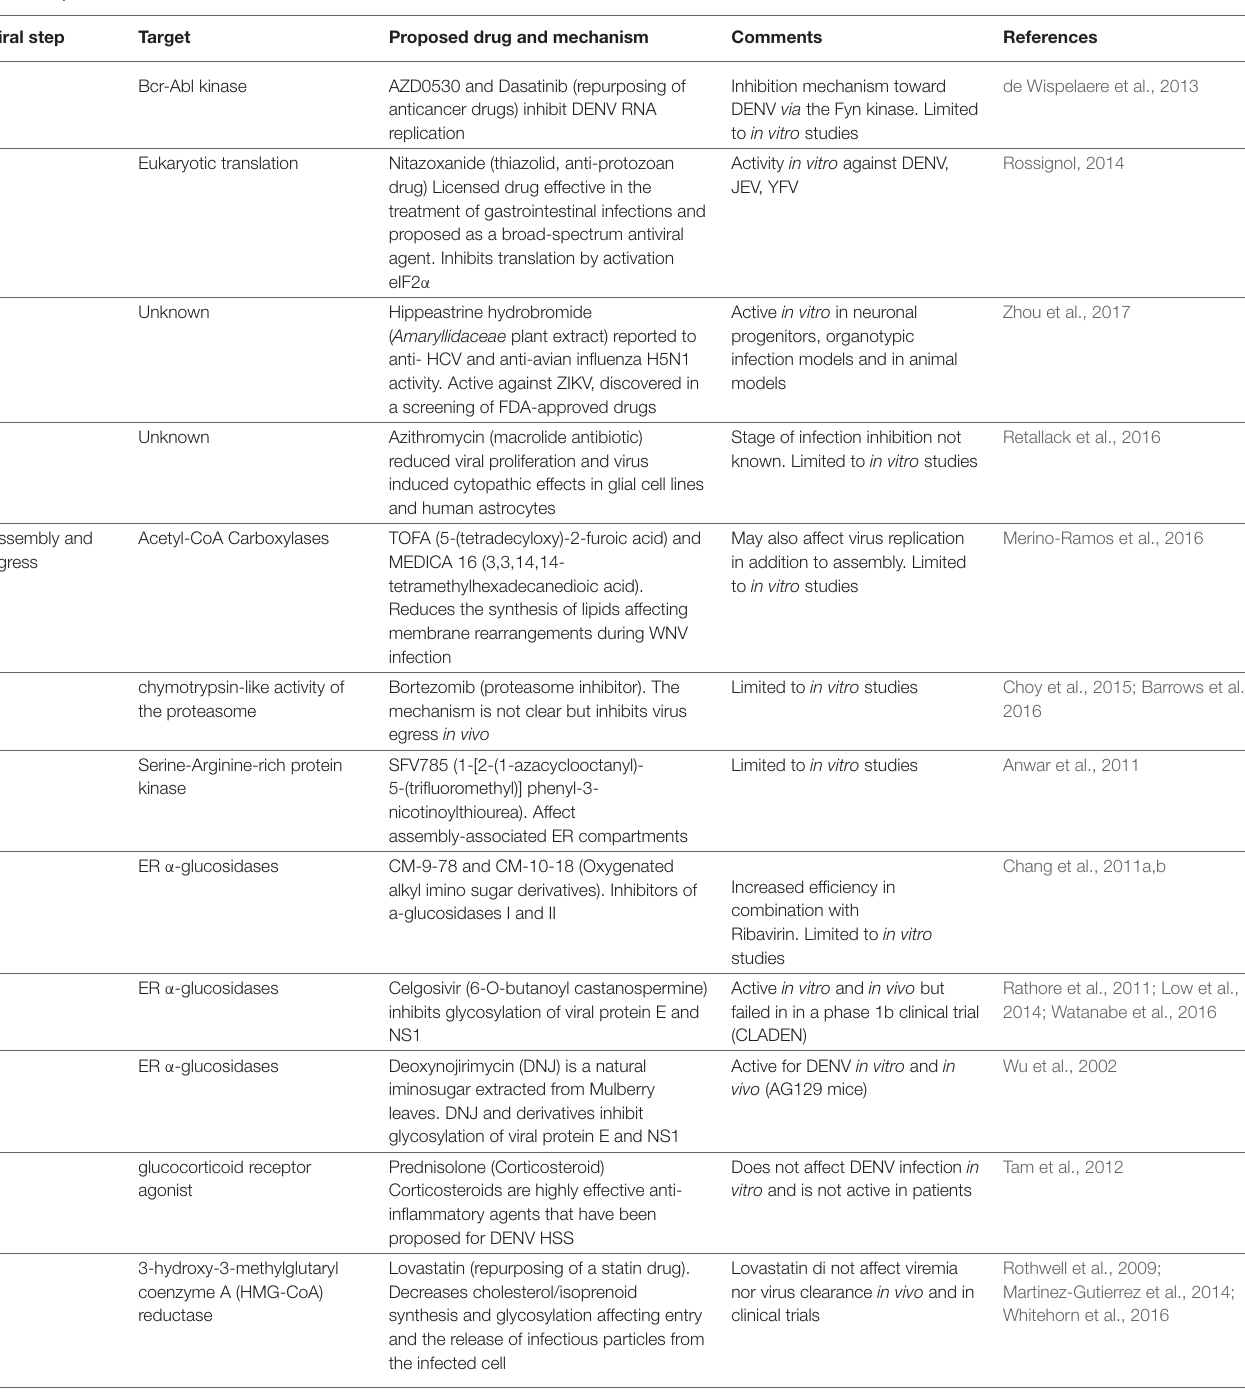
HTDdrugsobtainedbyavarietyoftop-downandbottom-upstrategiesthatshowedinhibitorypotentialtowardFlavivirusesarelistedtogethertotheirtarget(s)andproposedmechanism of action.